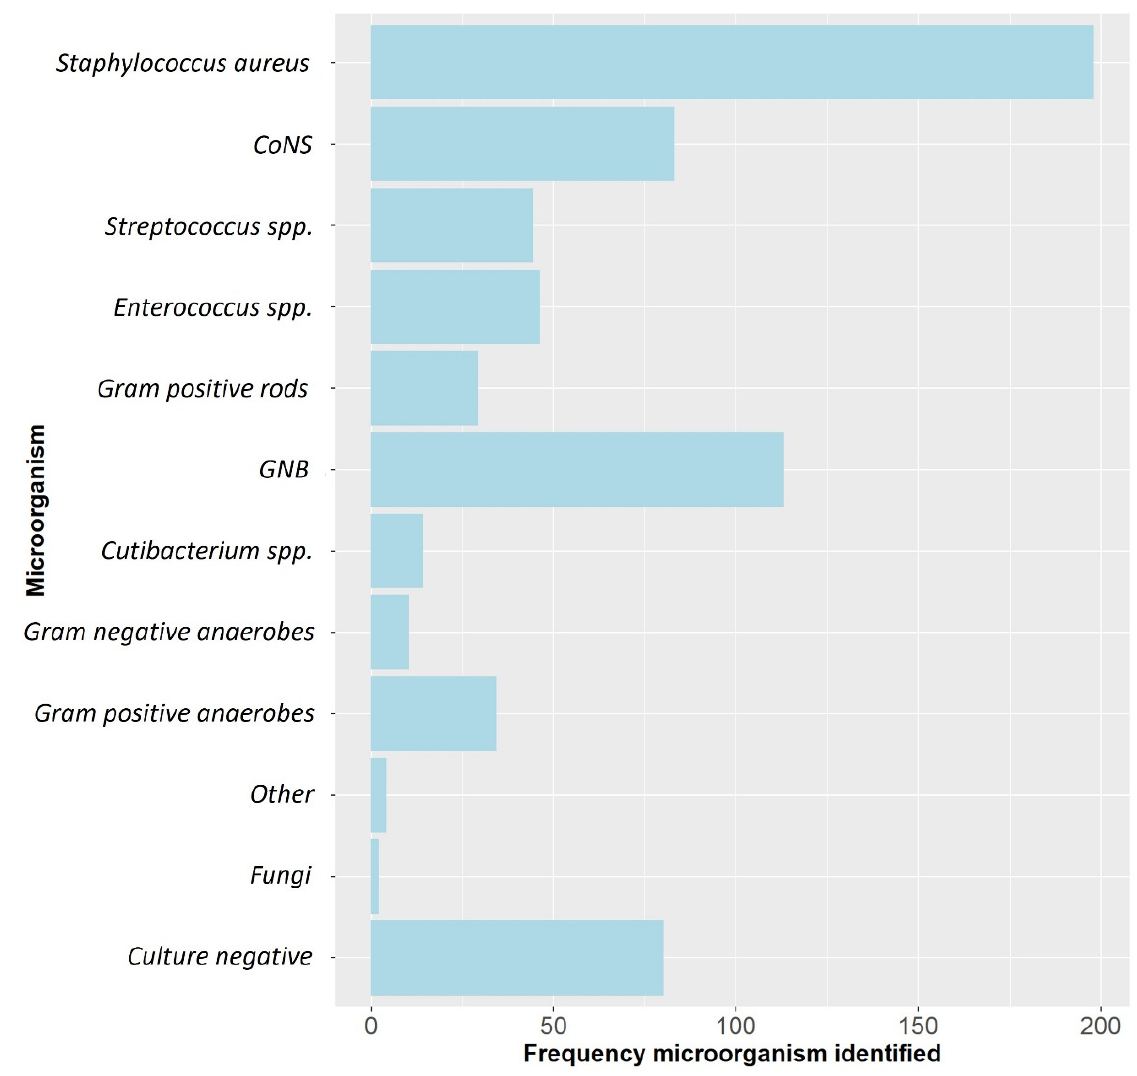
Figure 1. The microbiological epidemiology of this FRI cohort. CoNS: Coagulase-negative staphylococci, GNB: Gram-negative bacteria, spp: species.